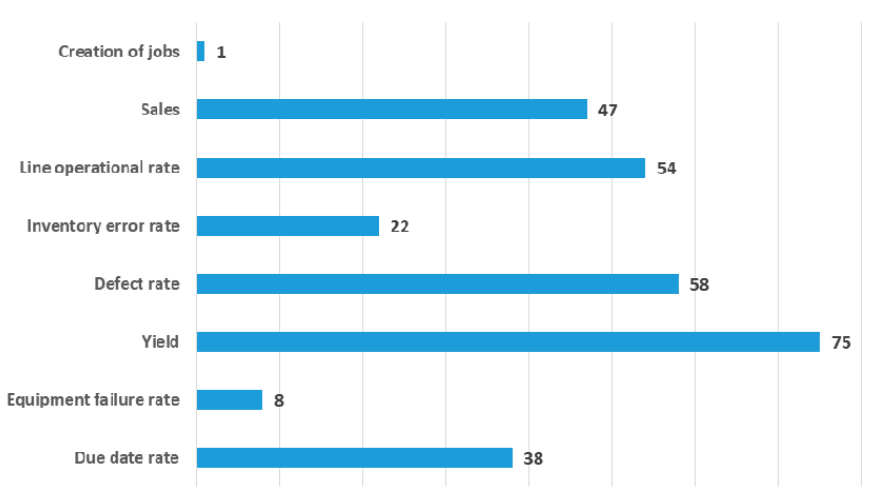
Figure 8. Key performance indicators (KPIs) of smart factory.